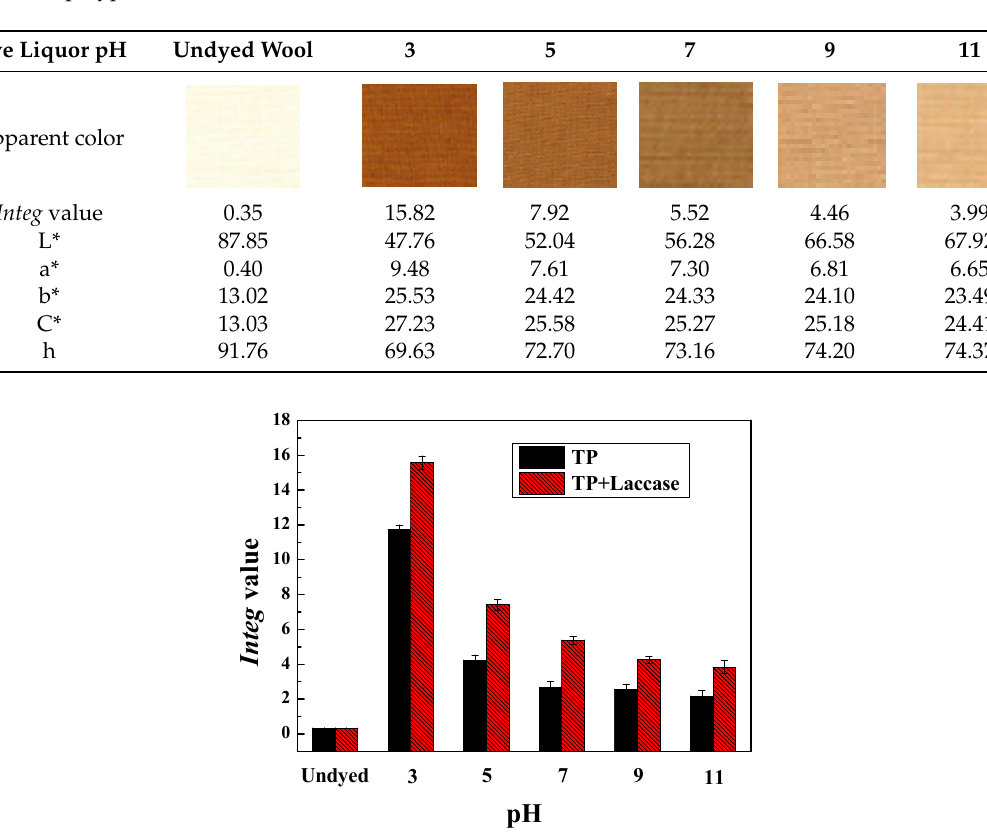
Figure 7. Effect of pH value on Integ value of dyed wool fabrics.